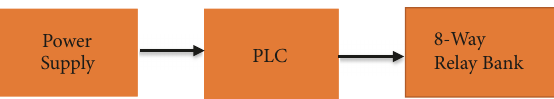
Figure 2: Block diagram of the controller unit.